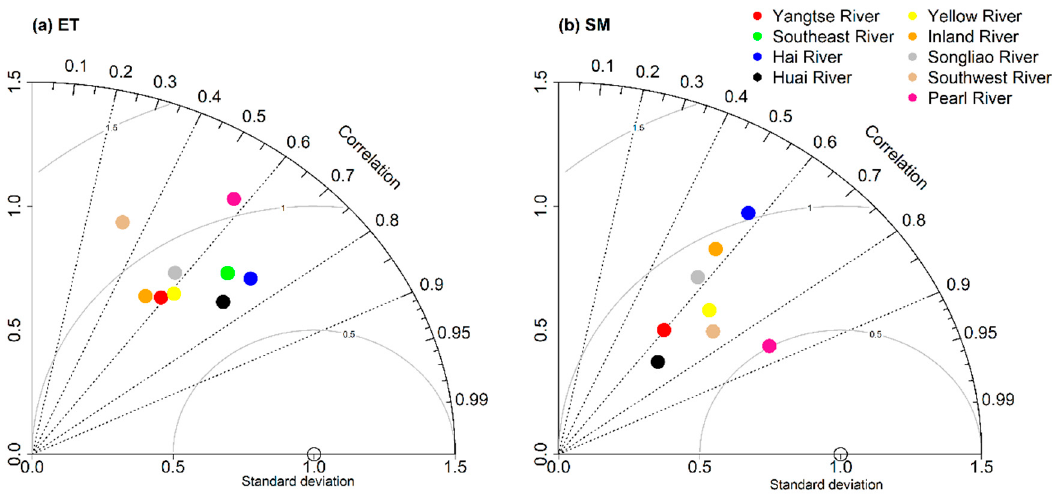
Figure 4. ET and SM evaluations with ground-based observations. The correlation coefficient (R) ( a , b ), bias ( c , d ), and RMSE (mm) ( e , f ) are presented.